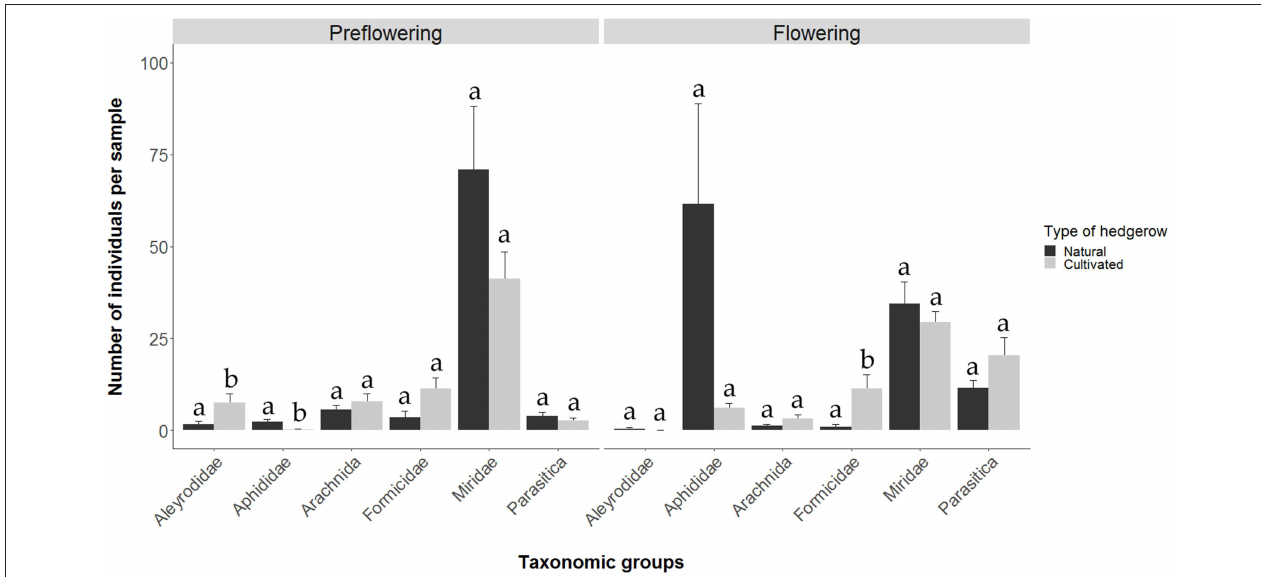
FIGURE 2 | Number of individuals (media ± SE) of the different taxonomic groups during the pre-flowering and flowering periods of D. viscosa plants in natural and cultivated hedgerows inside olive groves.